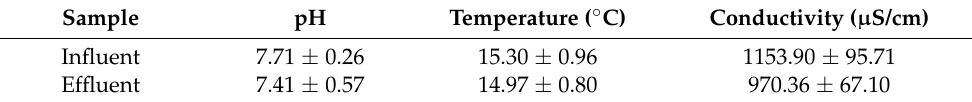
Table 7. Average values obtained for the parameters analysed in the influent and effluent.